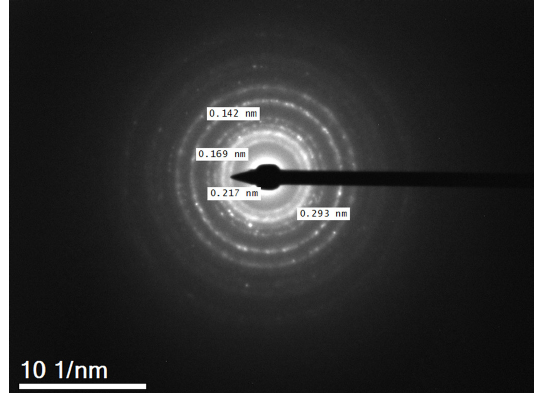
Figure 5. Electron diffraction for Fe-Nb material.